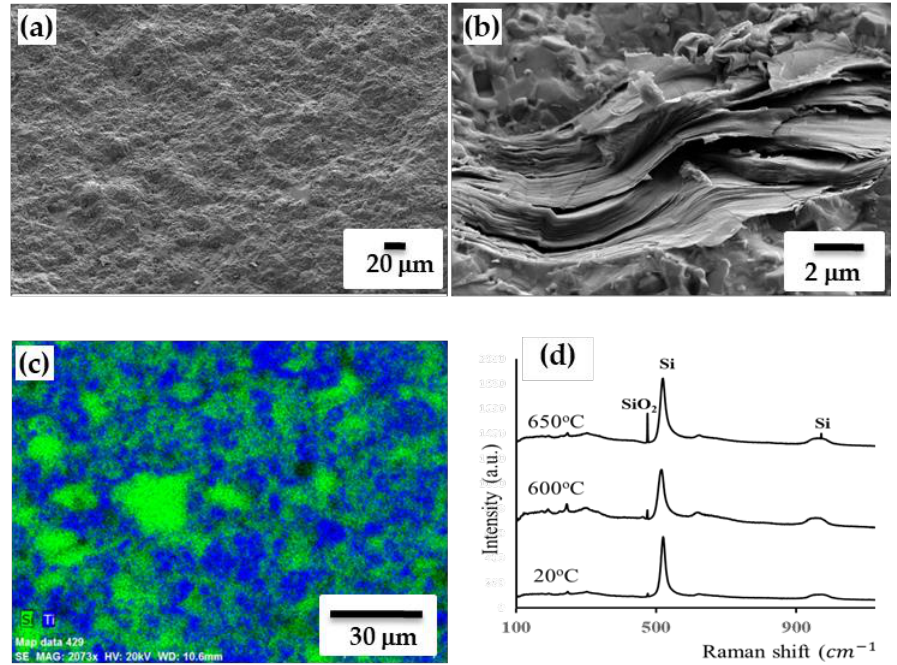
Figure 5. SEM images of ( a , b ) and EDS mapping ( c ) of TiB 2 -Si fracture surface after sintering (T = 1280 o C) and Raman spectrum after erosion by silica sand ( d ).